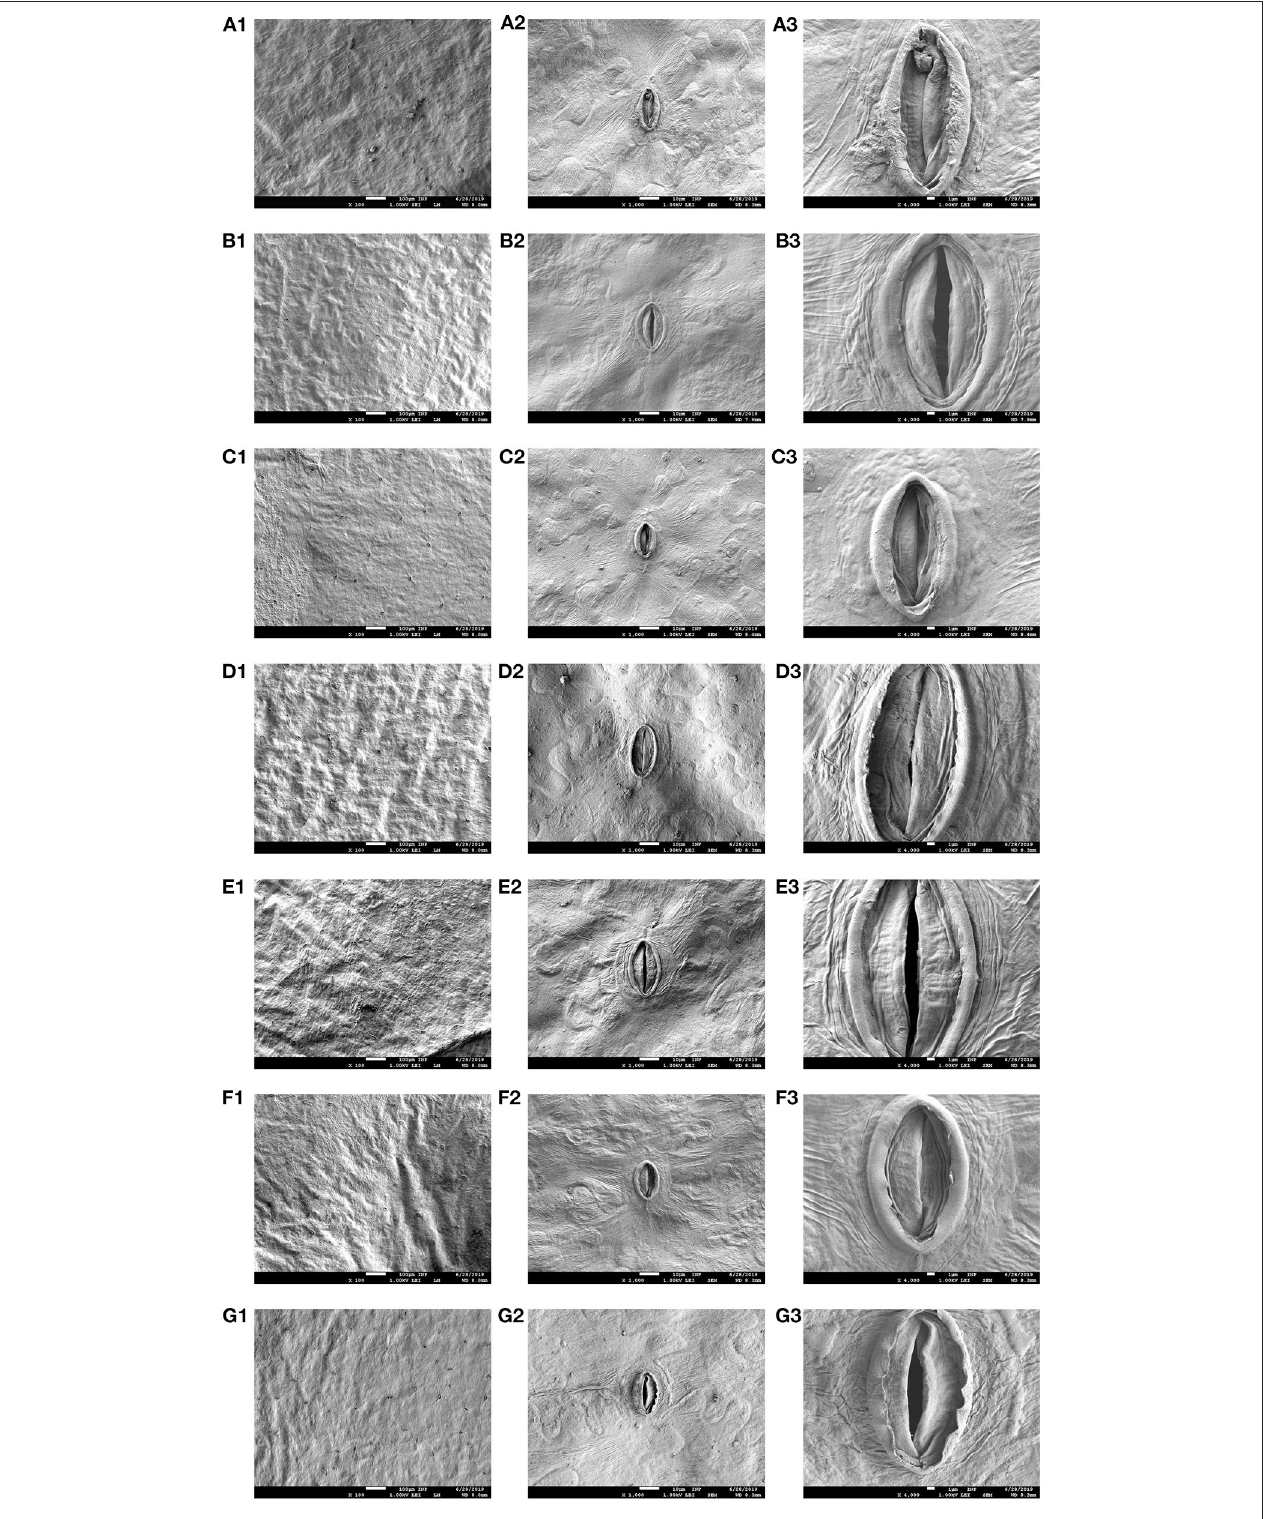
FIGURE 3 | Scanning electron microscopy (SEM) of the fresh-cut lettuce. For each process variant (I–VI), three magnifications are shown: left— × 100, middle— × 1,000, right— × 4,000. The scenarios shown are: (A) unwashed (extraction point 0), (B) tap water washed (variant I), (C) PTW washed—variant II, (D) PTW washed—variant III, (E) PTW washed—variant IV, (F) PTW washed—variant V, and (G) ClO 2 washed (variant VI).